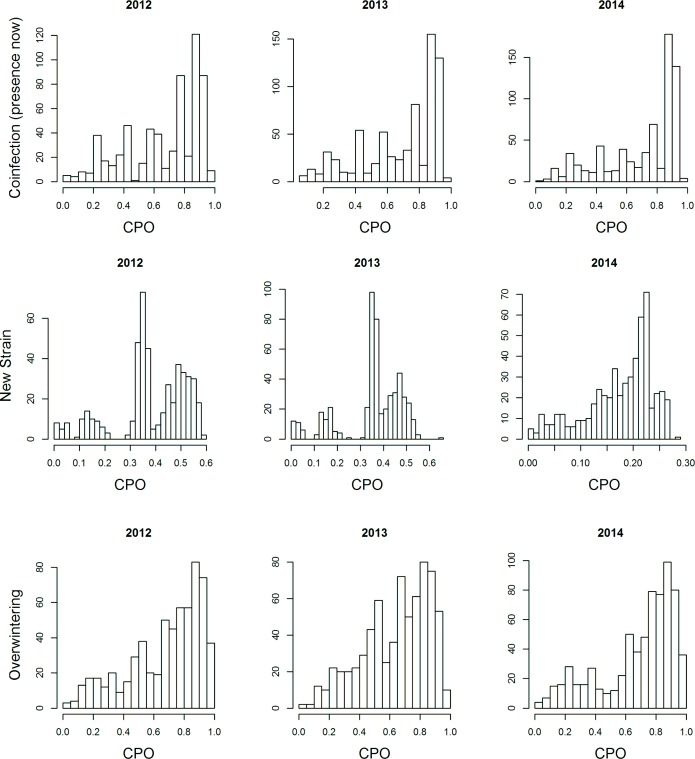
Distributions of the CPO-values for the four models for the different years.No particular temporal structure is visible indicating the adequacy of the models.